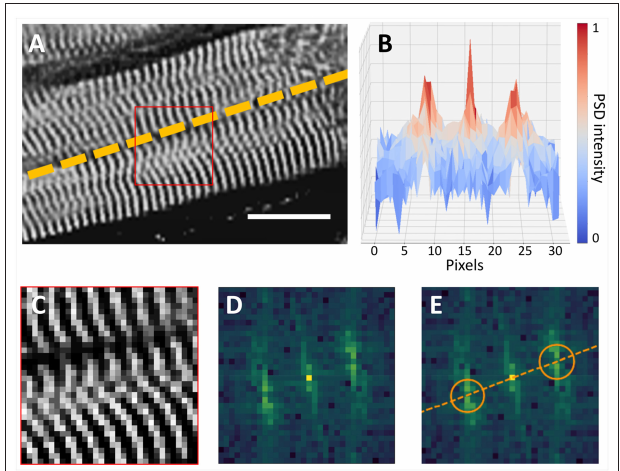
FIGURE 1 | Cardiomyocyte orientation by frequency analysis. (A) Cardiomyocyte long axis orientation (dashed line) is perpendicular with Z-bands (Scalebar: 16 µ m). (B) Intensity profile of the Power Spectrum Density (PSD) of the selection (red square) in (A) is shown in the XZ plane. (C–E) Myocyte orientation in the frequency space: (C) the 16 16 µ m selection of the × image in (A) is shown with the original pixel size; (D) frequency information contained in (C) ; (E) position of frequency peaks is highlighted (orange circles), and original myocyte long axis is restored.